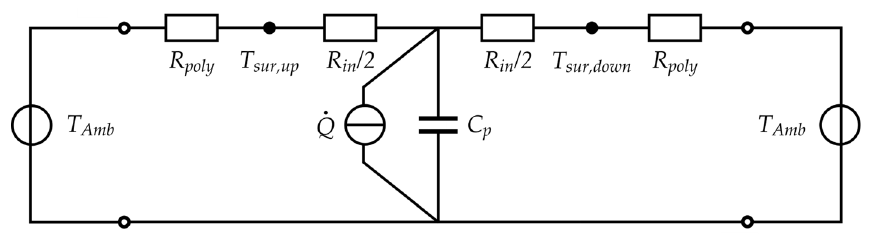
Figure 5. Representation of utilised model